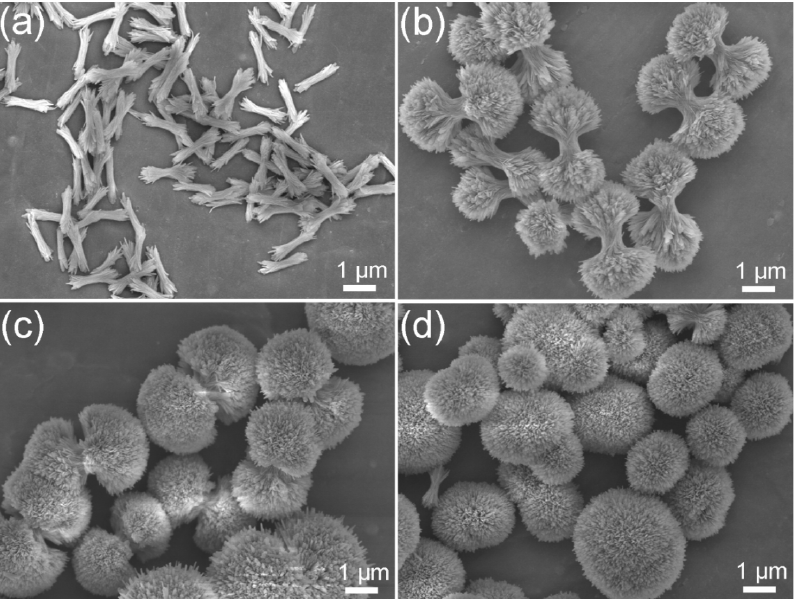
Figure 2. FE-SEM images of the CHA products synthesized by TSC and urea under different hydrothermal reaction temperatures and molar ratios of TSC/Ca. ( a ) 120 ◦ C, ( b ) 150 ◦ C, and ( c ) 180 ◦ C with n(TSC)/n(Ca) = 1, and ( d ) 180 ◦ C with n(TSC)/n(Ca) = 1:2.